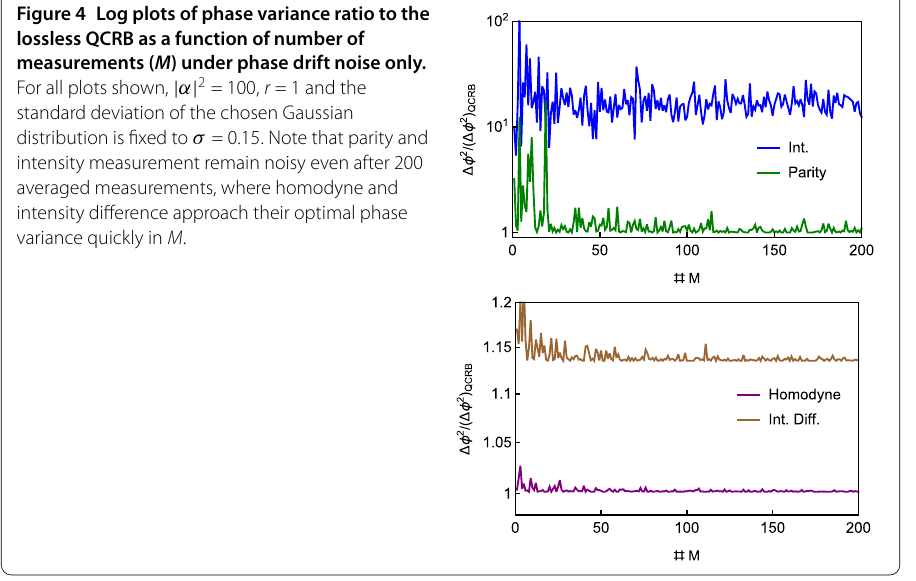
Figure 4 Log plots of phase variance ratio to the lossless QCRB as a function of number of measurements ( M ) under phase drift noise only. For all plots shown, | α | 2 = 100, r = 1 and the standard deviation of the chosen Gaussian distribution is fixed to σ = 0.15. Note that parity and intensity measurement remain noisy even after 200 averaged measurements, where homodyne and intensity difference approach their optimal phase variance quickly in M